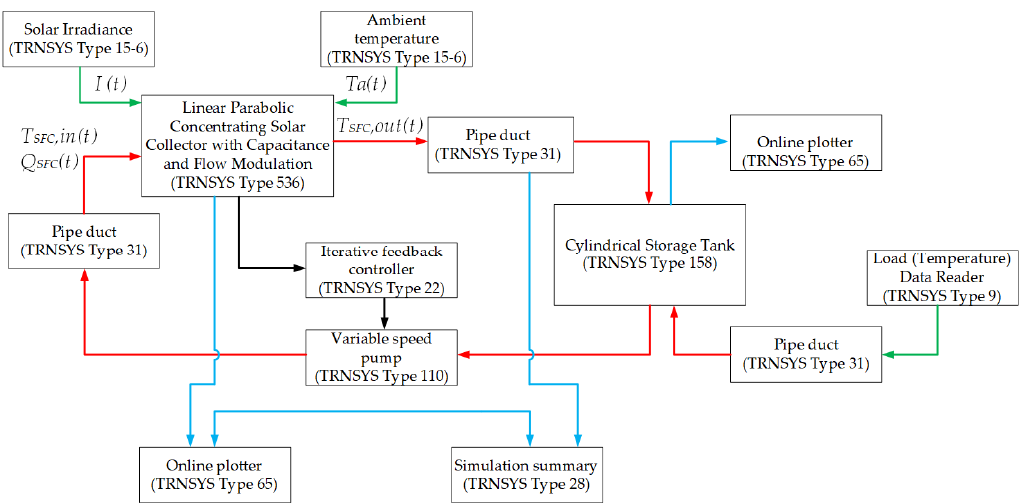
Figure 3. Model of Solar Collector Field (SCF) in Transient Systems Solution Program (TRNSYS).